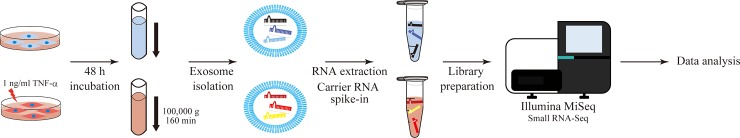
Experimental procedure of this study.Exosomes were isolated by ultracentrifugation from MH7A-conditioned media with or without TNF-α stimulation. Carrier RNA was used in the extraction step of exosomal RNAs. The extracted exosomal RNAs were sequenced on Illumina MiSeq.